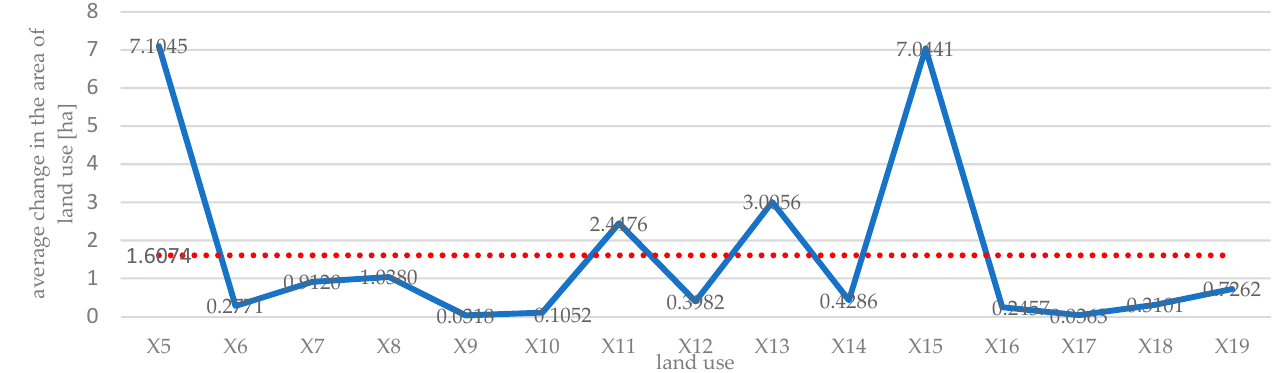
Figure 6. Average change in the area of land use [ha]. Source: own study.